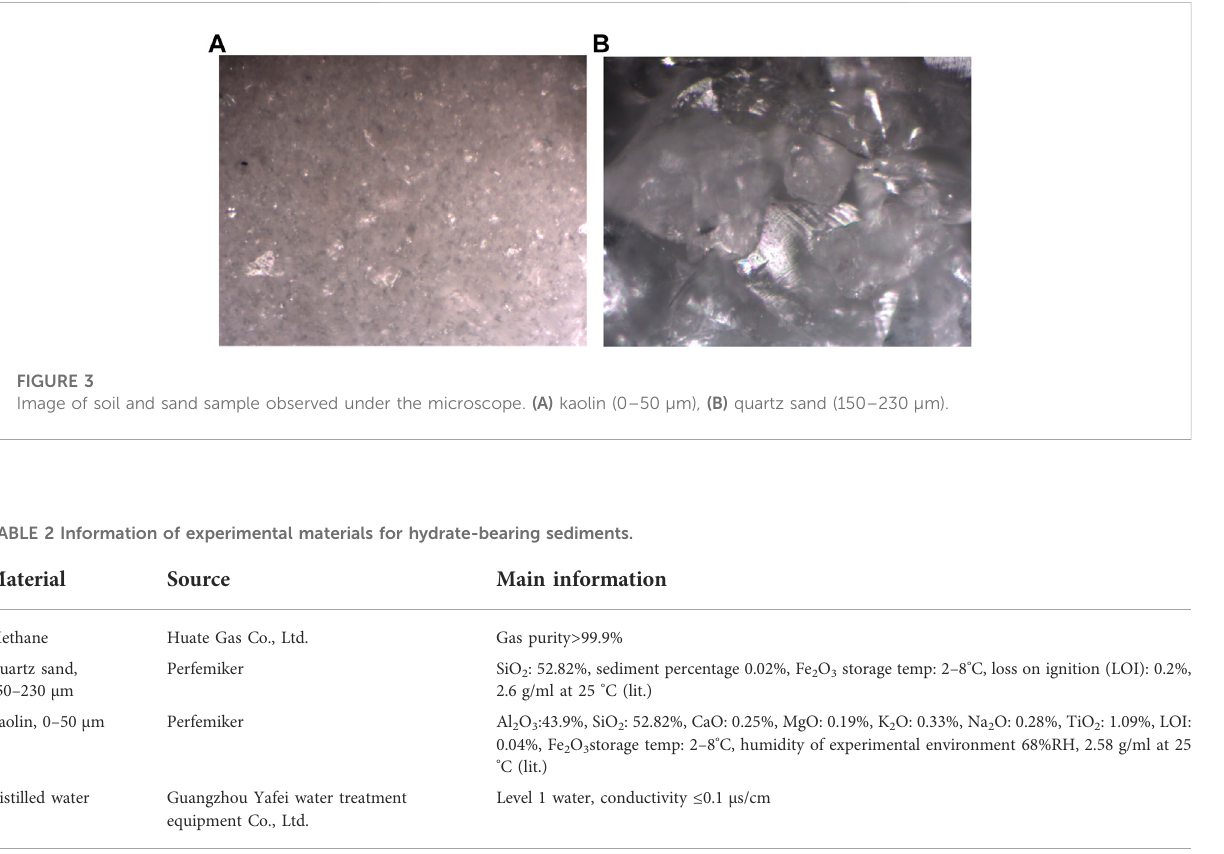
Table 2 for speci fi c information of experimental materials.